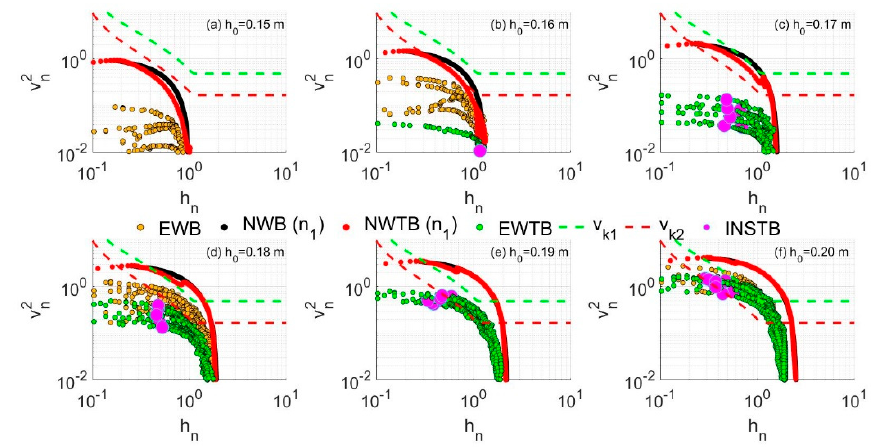
Figure 9. Instability diagram with experimental and numerical data of the cases from h 0 = 0.15 m to h 0 = 0.20 m, denoted from ( a ) to ( f ) in subfigures ( v k1 and v k2 are the calculated instability velocities for C D = 2 and C D = 6). For the meaning of EWB, NWB, EWTB and NWTB see caption of Figure 8. When the initial water basin is higher, the influence of the block on the impacting flow is not so large. However, the block significantly contributes to the reduction of the flow velocity (see ( b ) and ( d )), which has not been reproduced by the numerical model. The INSTB dots represent the flow properties at the exact moment when the block is mobilized. We neglect some flow velocity data for the case of h 0 = 0.16 m since they are really chaotic.